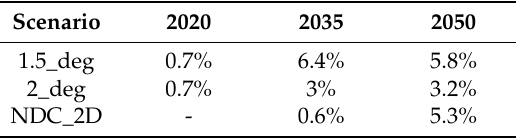
Table 4. GDP loss in different scenarios.